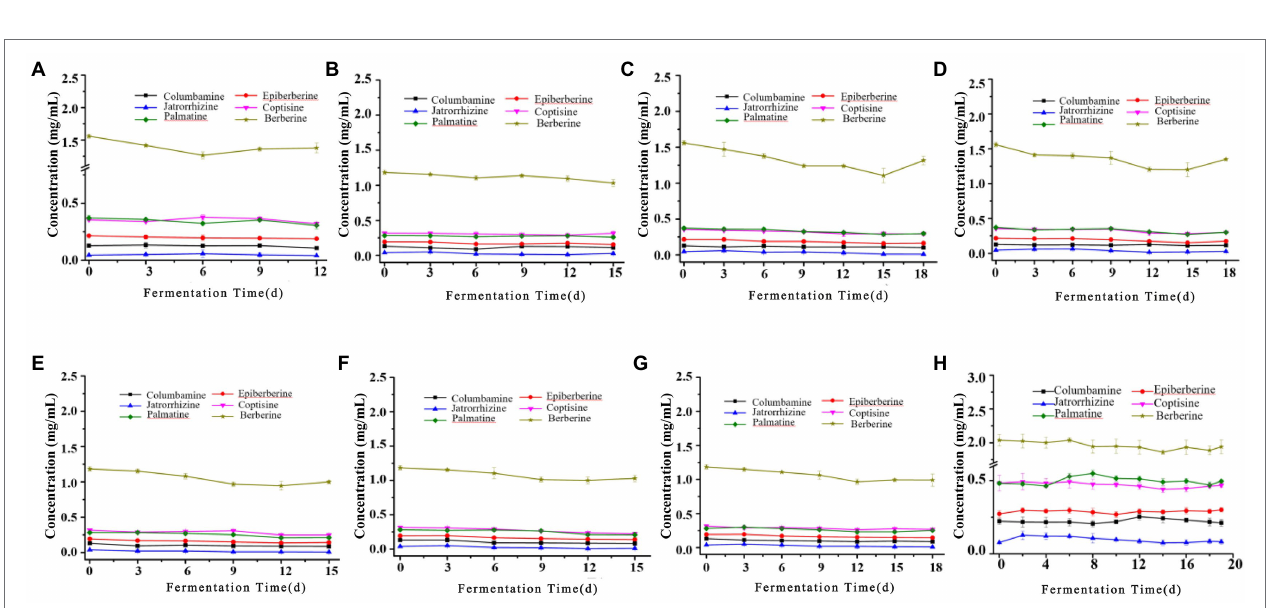
FIGURE 6 | Content of iridoids during fermentation of LZF by monoculture fermentation and natural fermentation. (A) Penicillium expansum YY-46; (B) Penicillium qlabrum YY-51; (C) Aspergillus niger YY-9; (D) Aspergillus japonicus YY-5; (E) Cladosporium oxysporum YY-19; (F) Cladosporium tenuissimum YY-23; (G) Cladosporium cladosporioides YY-34; and (H) natural fermentation.